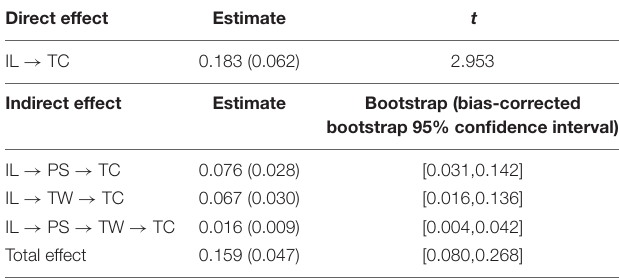
TABLE 3 | Path coefficients and indirect effects in the mediation